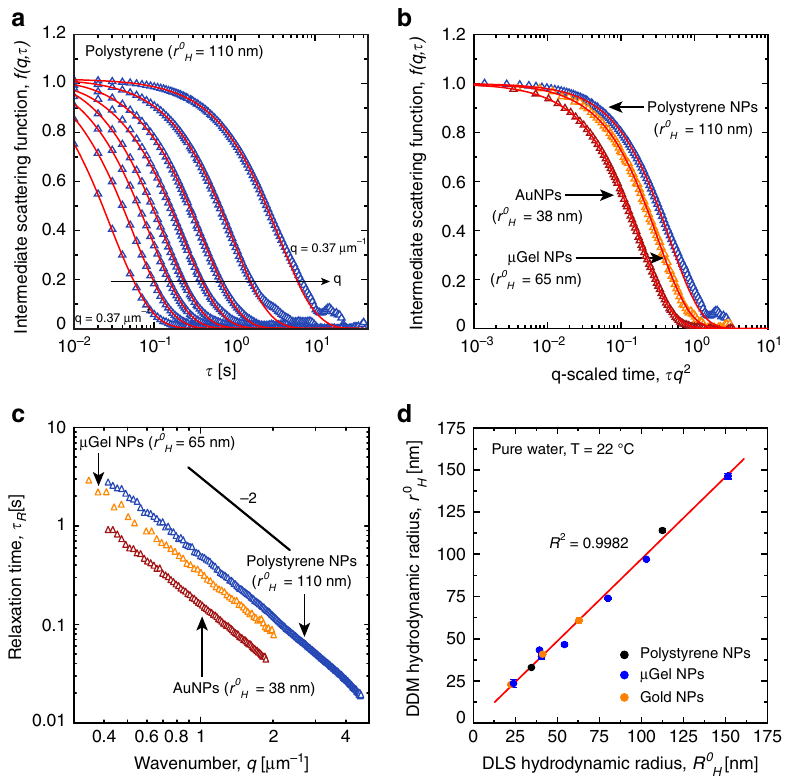
Fig. 1 Dynamics of soft and hard nanoparticles in pure water at volume fractions ϕ < 0.1%. a DDM intermediate scattering functions extracted from g(q, τ ) functions using Eq. (1), showing the dynamics over a large sample of q . b Intermediate scattering functions as a function of the spatial-frequency-scaled time for hard NPs (blue triangle, q = 0.37 μ m − 1 , red triangle q = 0.57 μ m − 1 ) and soft NP (orange triangle, q = 0.63 μ m − 1 ). c Relaxation time τ R vs q for different soft and hard NPs radii. Data shows the typical scaling relation between τ R vs q with an exponent of − 2. d Comparaison of the hydrodynamic radius obtained from DDM ( r 0 H ) and DLS ( R 0 H ). The red line is a linear least square fi t to the data (slope = 0.972 ± 0.012) with its corresponding R 2 value. Numerical values for hydrodynamic radius are provided in Supplementary Table